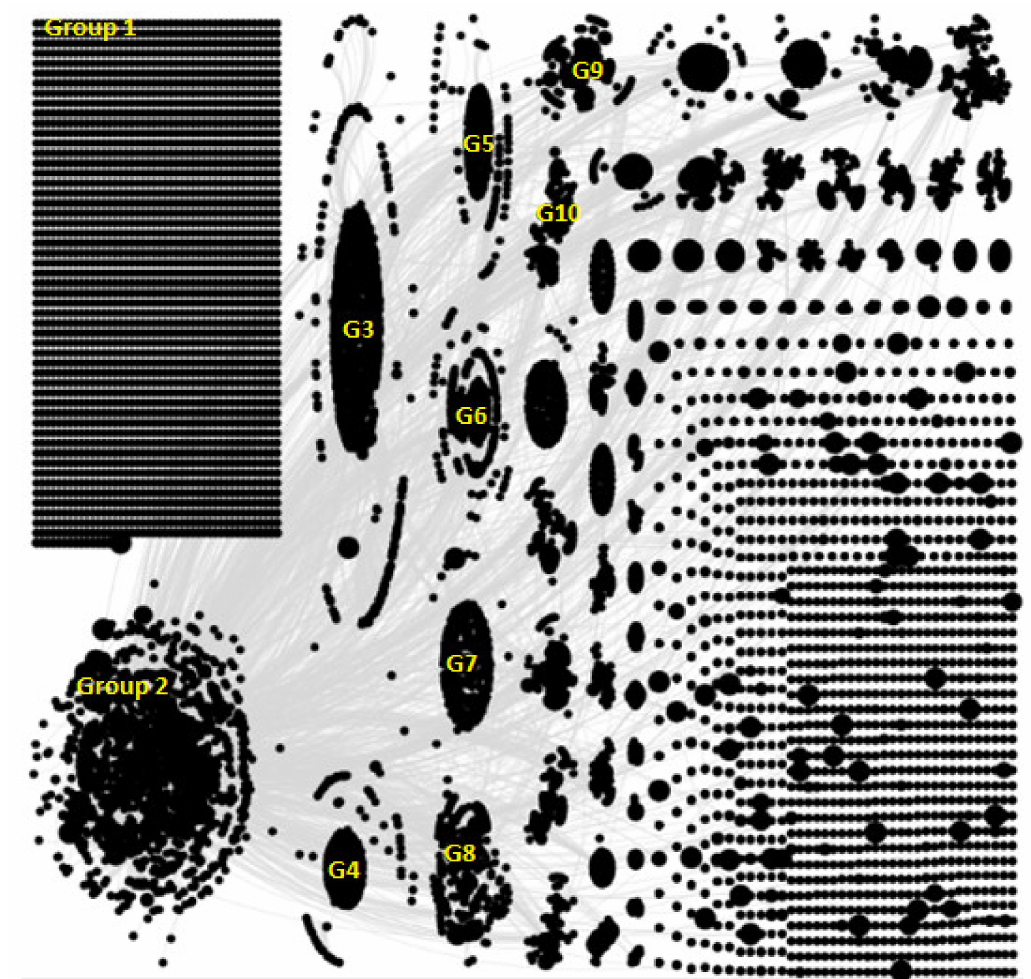
Figure 1. Tweets related to e-cigarettes in October